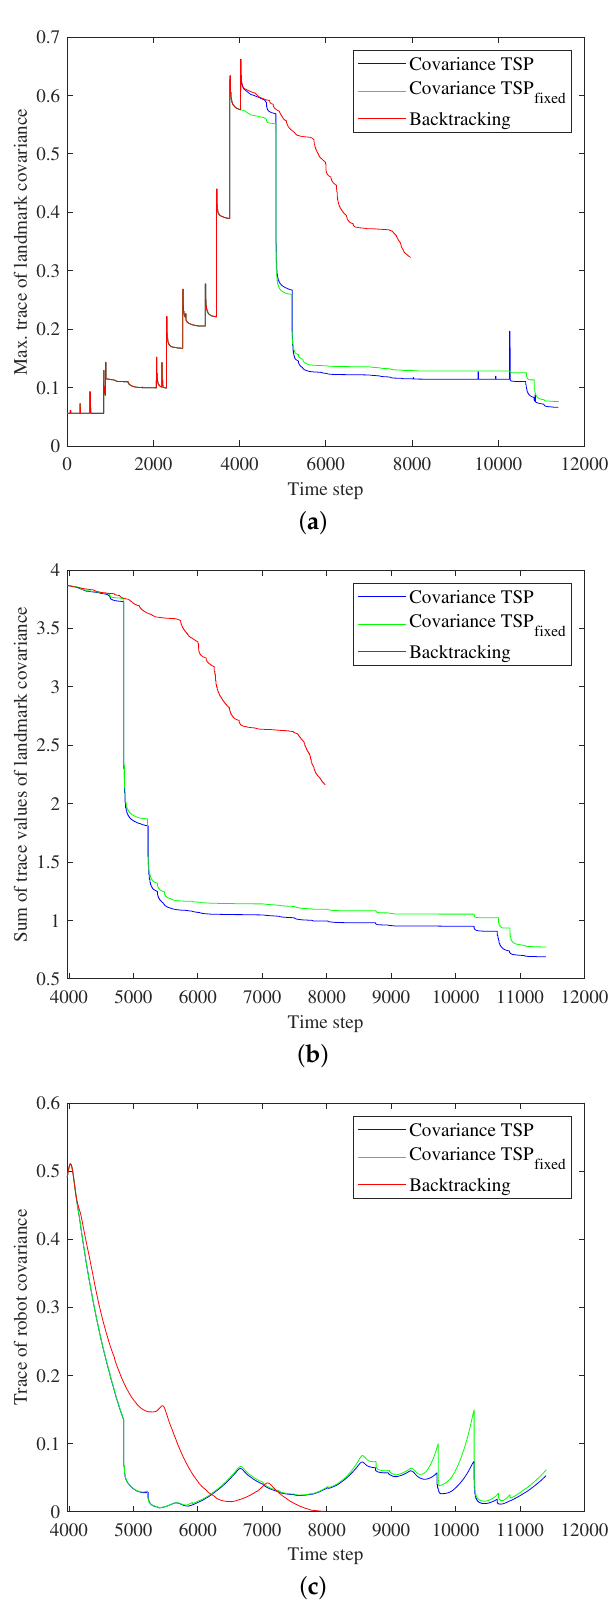
Figure 10. Comparisons of the proposed methods and backtracking: ( a ) The maximum trace value of landmark covariance matrix. ( b ) The sum of the trace values of the landmarks registered until the time when revisiting was planned. ( c ) The trace of the robot covariance